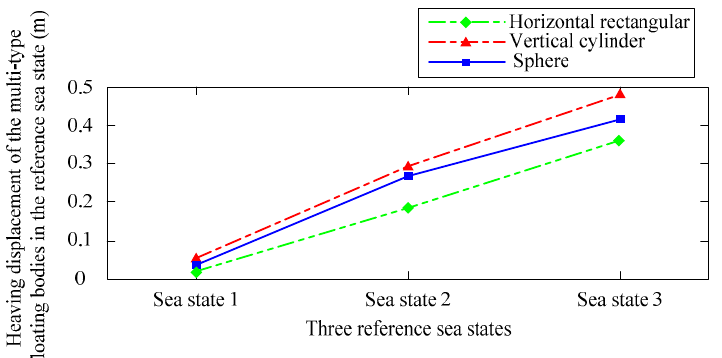
Figure 9. The heaving velocity of the multi-type floating bodies in the reference sea state.